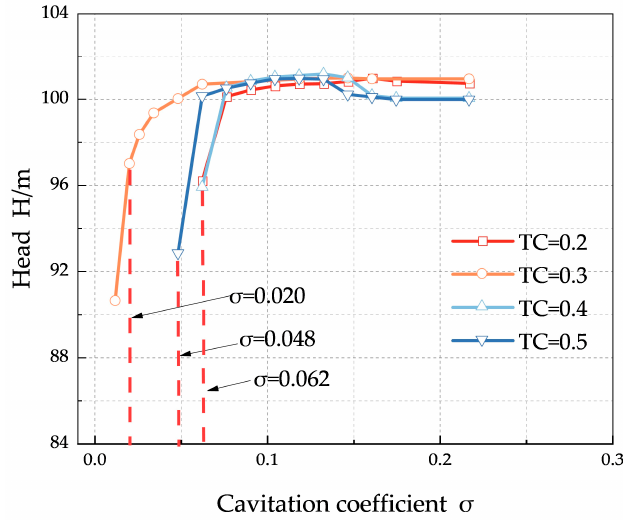
Figure 5. Cavitation performance curves of the centrifugal pump under different TCs.